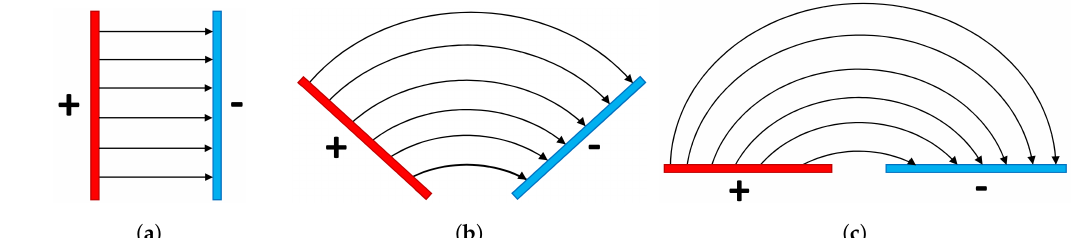
Figure 1. Schematic of the electric field distribution as electrodes turns from a parallel geometry of the capacitor (left) to coplanar (right): ( a ) Parallel-plate capacitor whose, ( b ) Electrodes open up to provide, and ( c ) One-sided access to the